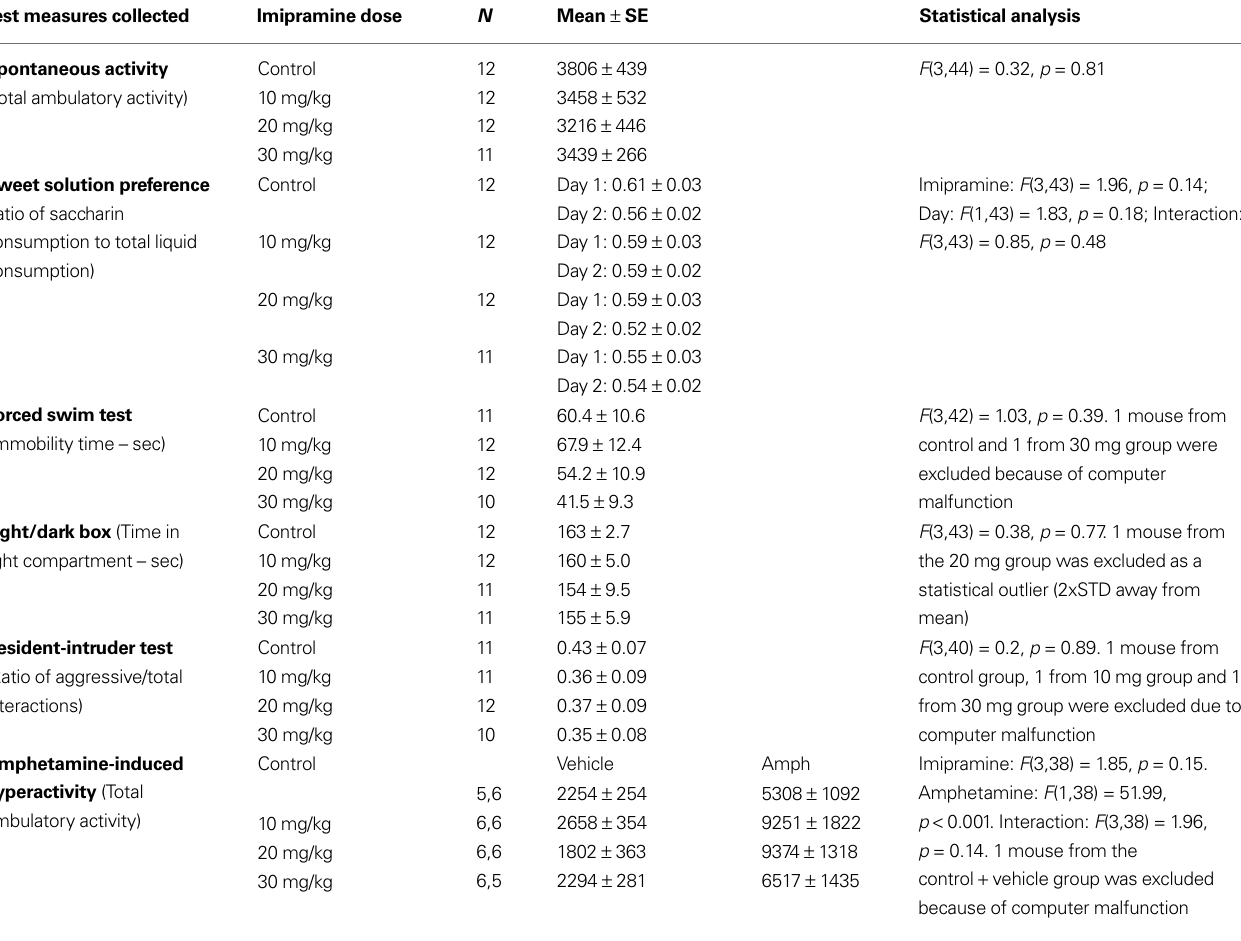
Table 2 | Behavioral effects of imipramine administration in tests for domains of